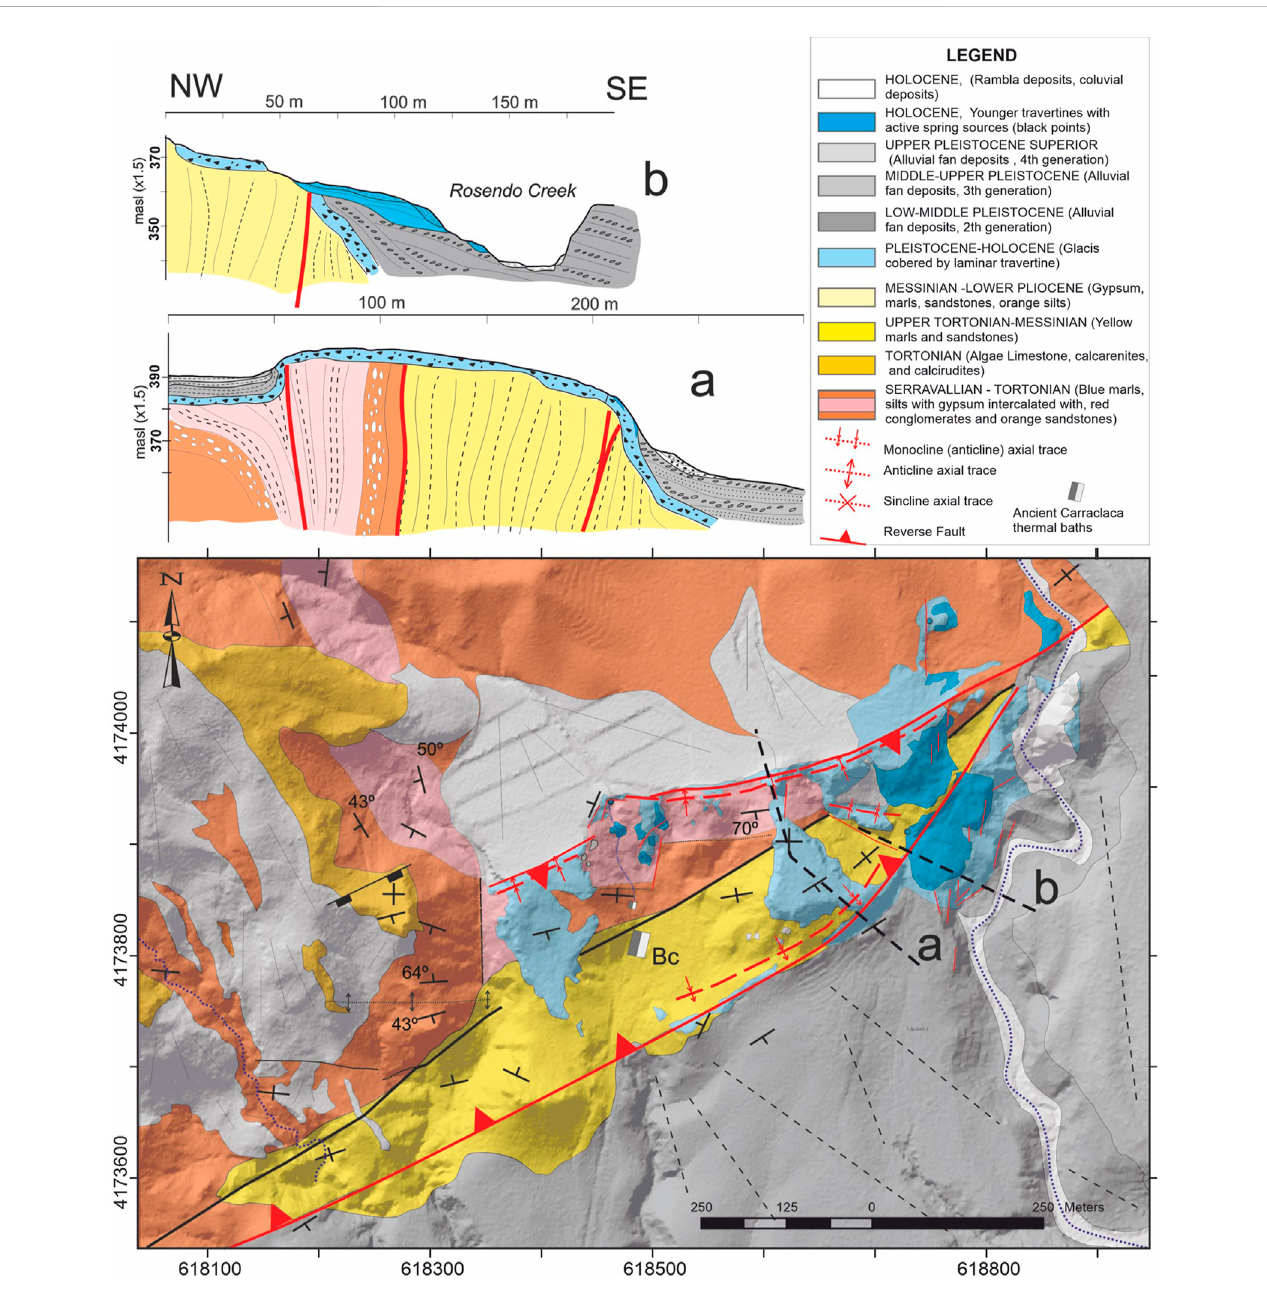
FIGURE 2 Geological-structural map of the Carraclaca area showing main fault traces and travertine deposits and related geological cross sections through the pop-up structure.